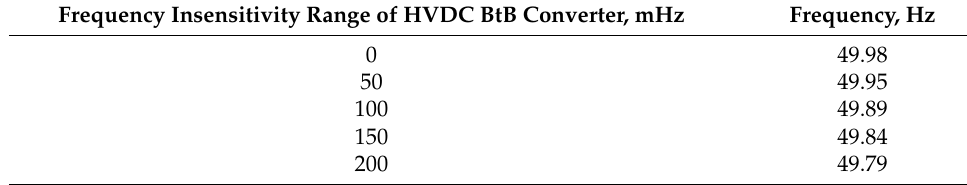
Figure 23. Voltage fluctuations on the 330 kV side. Table 5. Frequency change in the isolated power system.